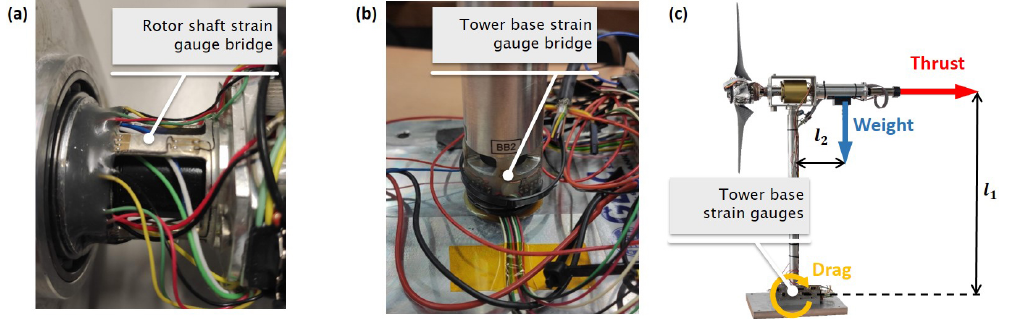
Figure 5. The rotor shaft, with its strain gauge bridge (a) ; tower base, with its own integrated load cell (b) ; schematic representation of the forces acting in the fore–aft direction on the model, and the respective moments induced at the strain gauge position (c)